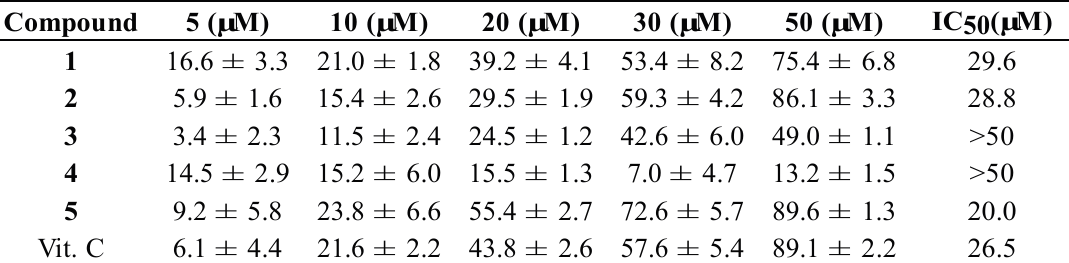
Table 2. DPPH radical scavenging activity of isolated compounds.